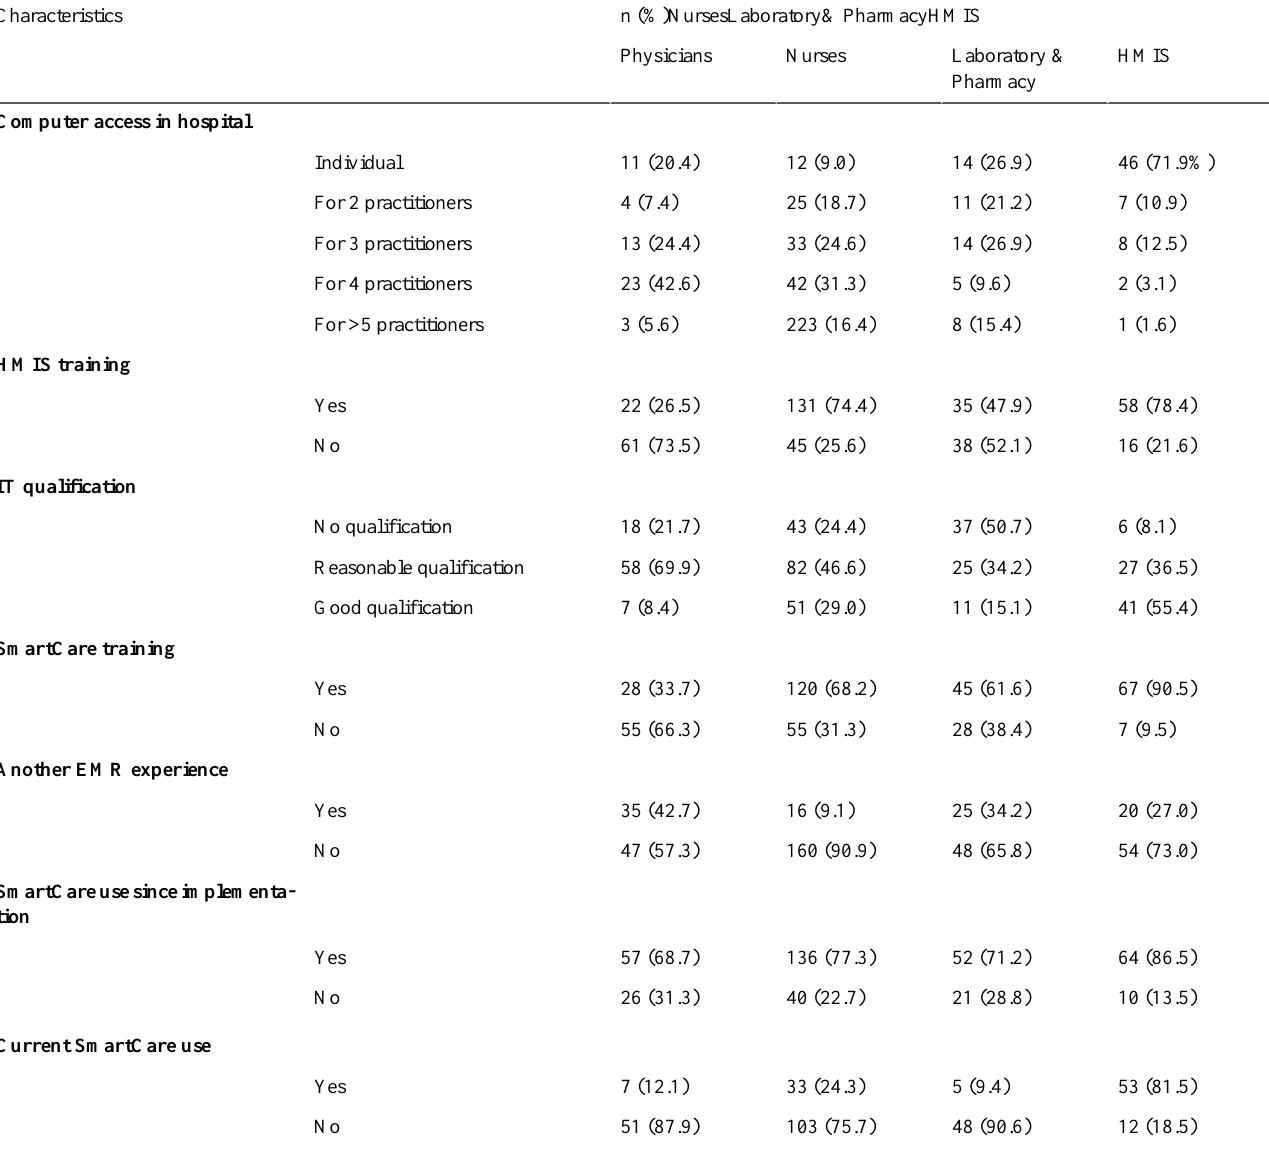
Table 2. Training, information technology (IT) qualification, experience, and current EMR use status of physicians, nurses, laboratory, pharmacy, and HMIS staff in the study participants